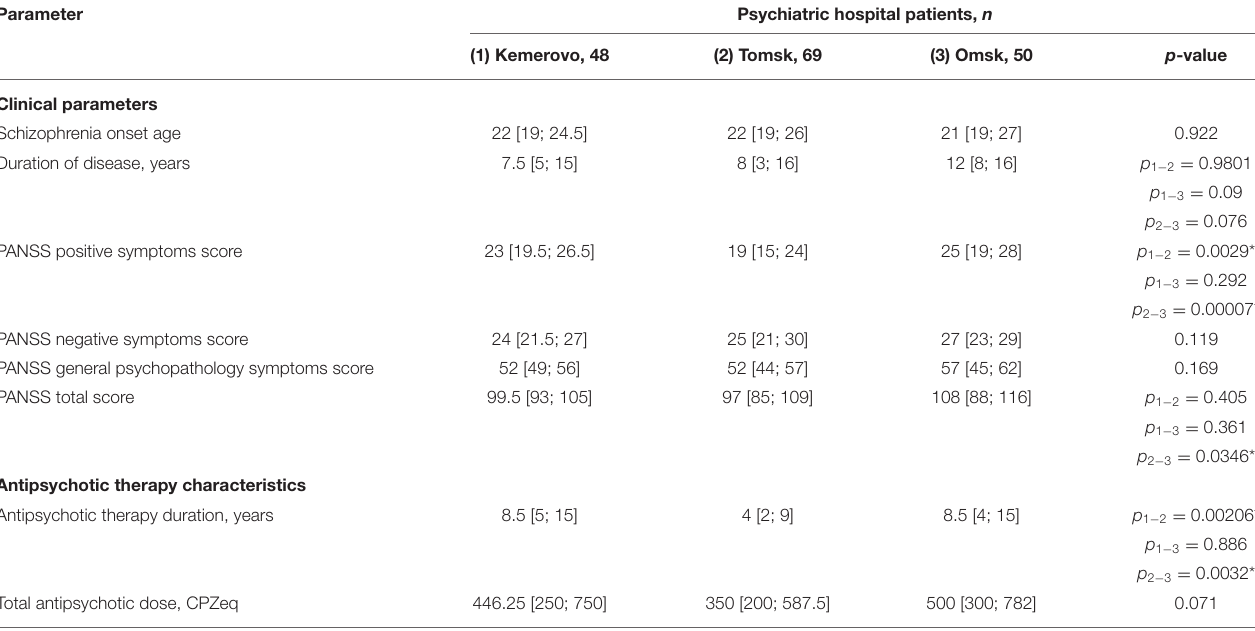
TABLE 4 | Comparative characteristics and evaluation of clinical parameters and antipsychotic therapy in the male part of the study population (Me [Q1; Q3]). Parameter